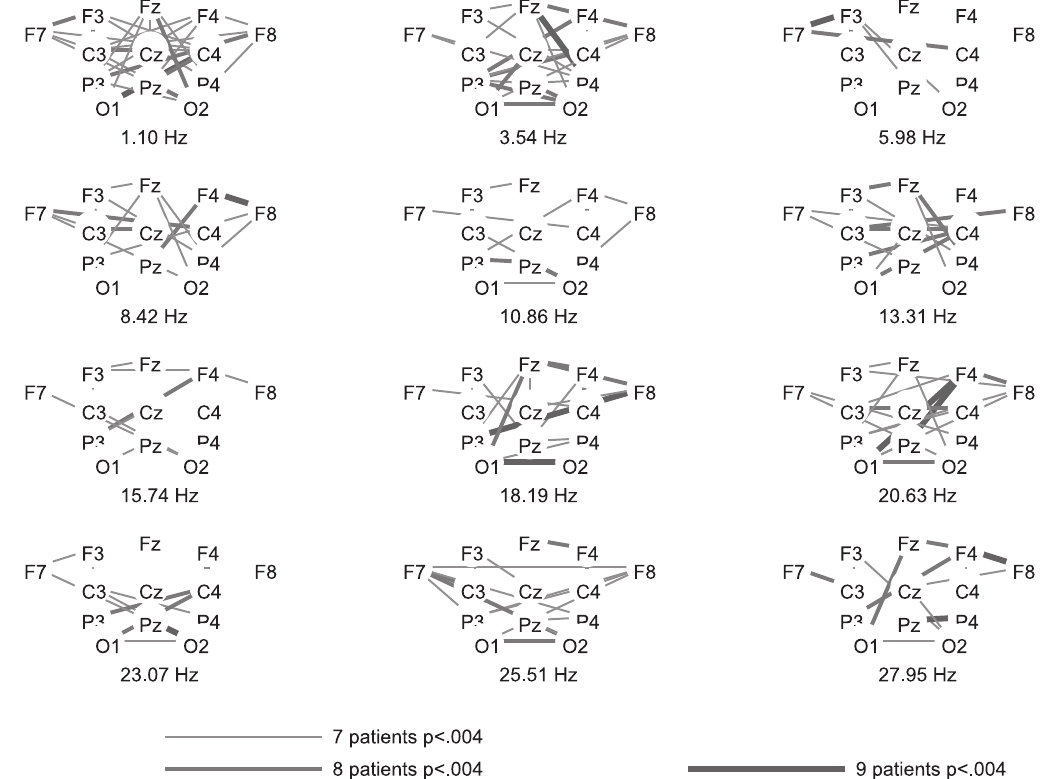
Figure 7. Numbers of patients with UWS with significant (FDR-corrected) coherences.